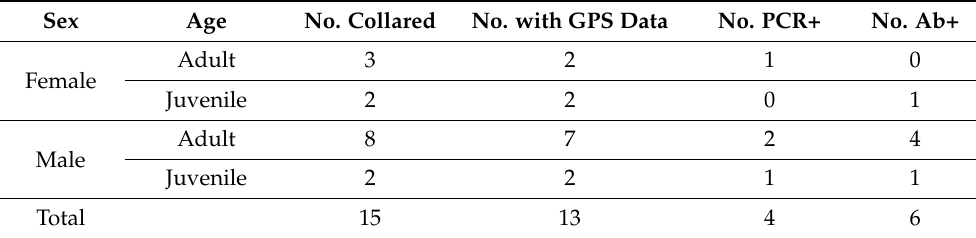
Table 1. Results for SARS-CoV2 qRT-PCR and antibody testing for the 15 cats captured and fitted with GPS collars on mink farms.